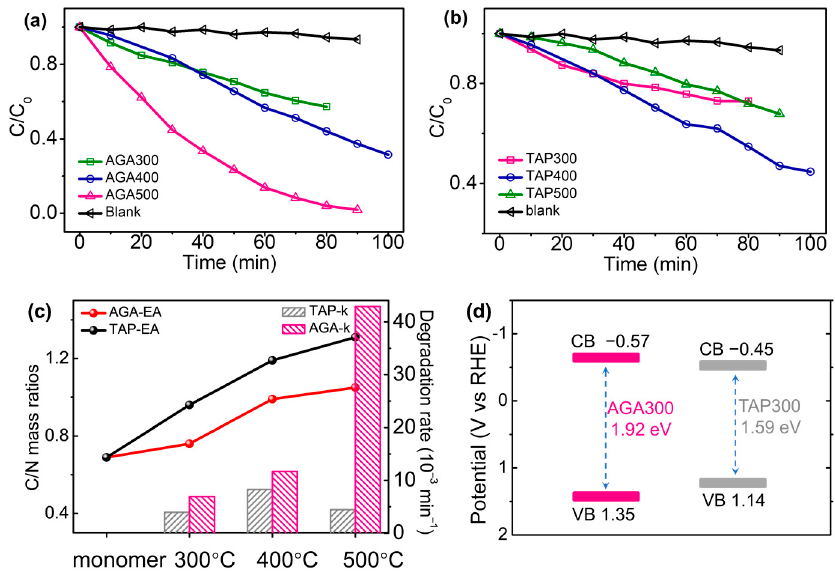
Figure 3. Relative concentration of rhodamine B (RhB) as a function of illumination time for ( a ) AGA- and ( b ) TAP-derived materials. ( c ) C/N mass ratios and kinetic degradation rate k as functions of the calcination temperature for AGA- and TAP-derived materials. ( d ) Estimated band structures of AGA300 and TAP300.